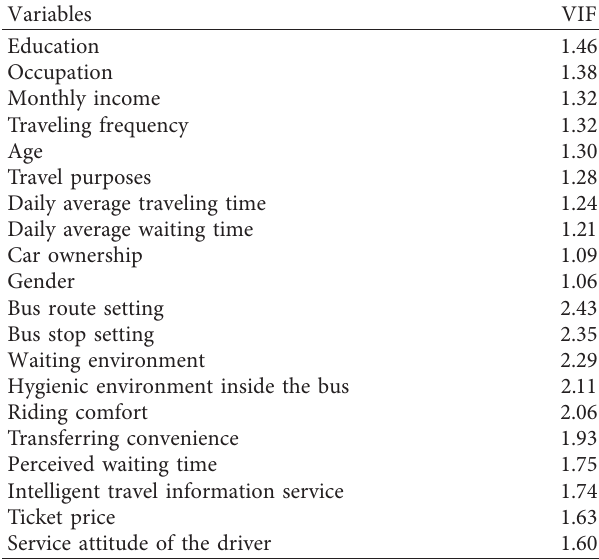
Table 4: Collinearity results of independent